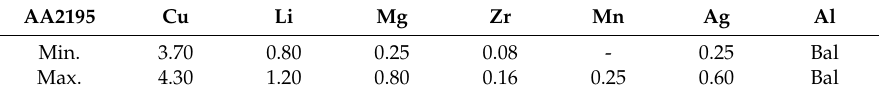
Table 1. Composition of AA2195 alloy